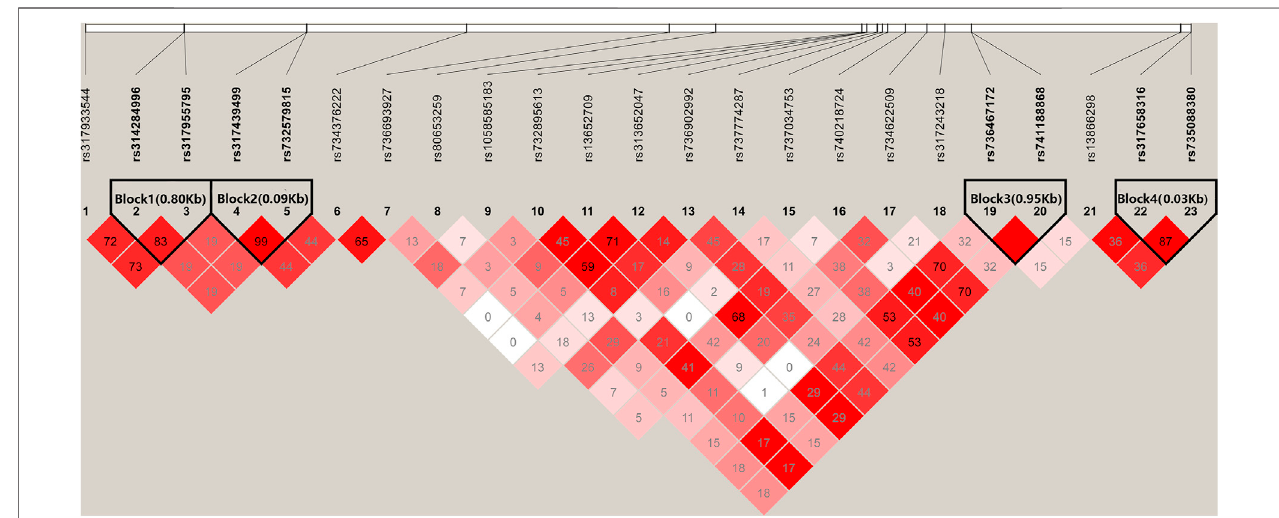
FIGURE6| Linkagedisequilibriumanalysisofsigni fi cantSNPs.ValuesinboxesareLD( r 2 )betweenSNPpairs. Theabsenceofthe r 2 valuewithintheboxesmeans